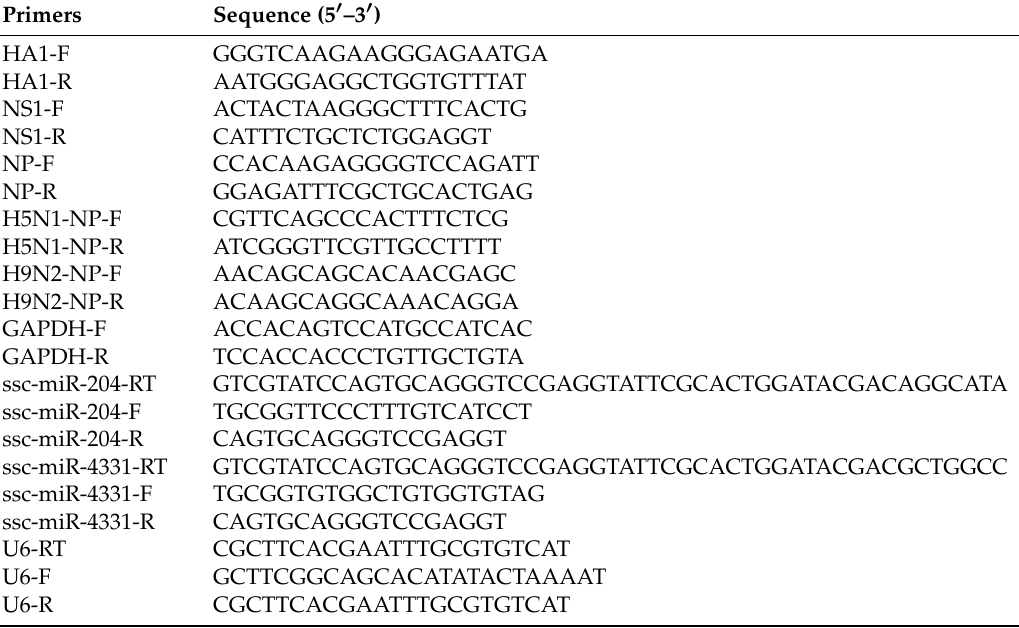
Table 5. Primers for